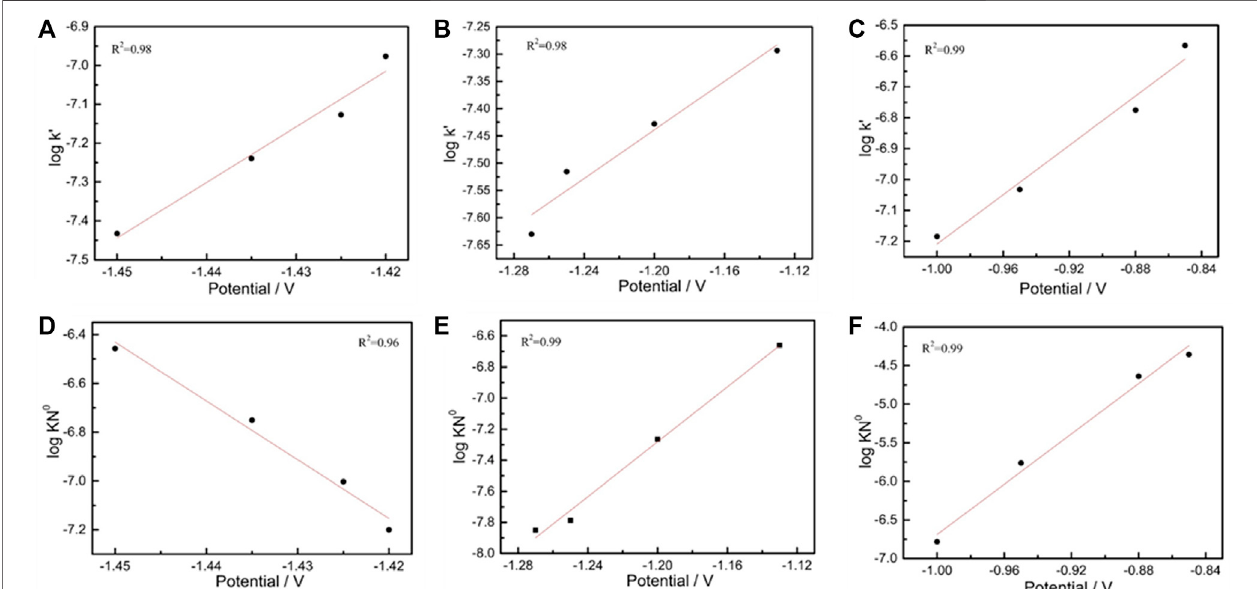
FIGURE 3 | Plot of the logarithm of vertical growth rate constant lg ( K ′ ) (A – C) . Plot of the logarithm of vertical growth rate constant lg ( K 2 N o ) (D – F) .